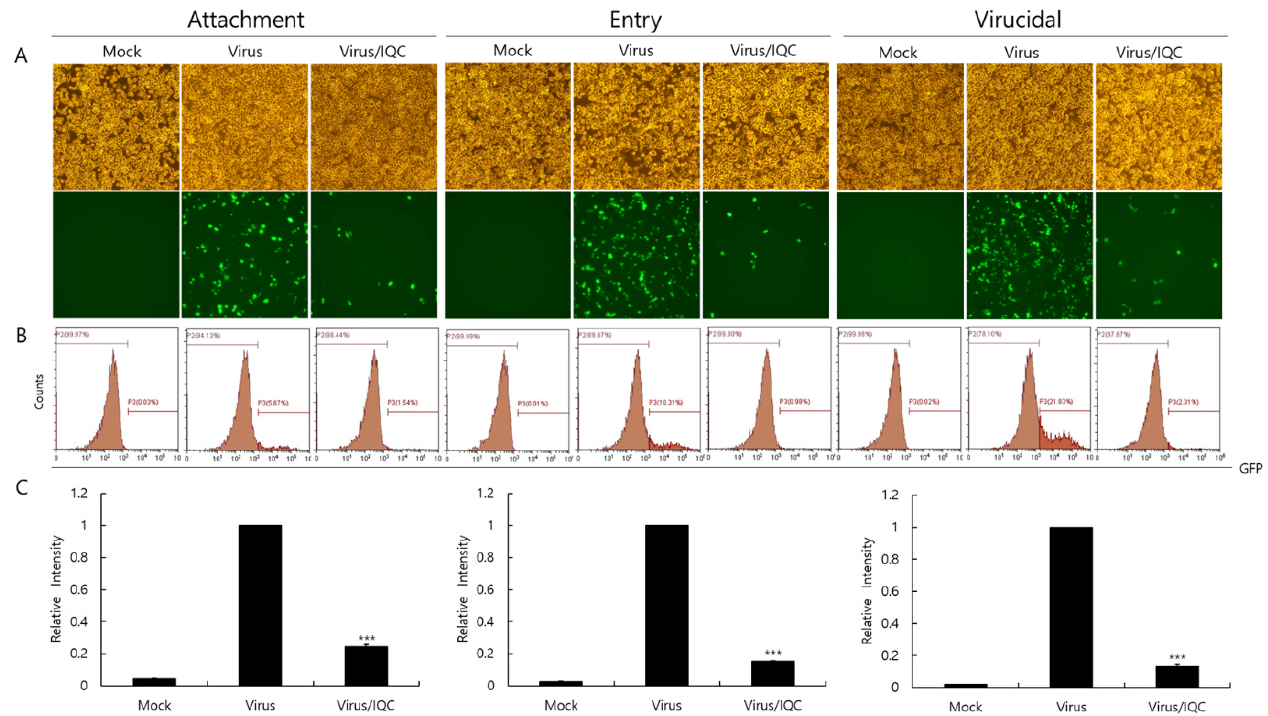
Figure 4. Effect of isoquercitrin on viral attachment, entry, and virucidal stages. ( A – C ) For checking the effect of IQC on the attachment stage, RAW 264.7 cells were cotreated with PR8-GFP IAV at 10 MOI and IQC at 25 µ M for 30 min at 4 ◦ C. After washing, the cells were incubated for 24 h at 37 ◦ C. To examine the effect of IQC on the entry stage, the cells were infected with 10 MOI PR8-GFP IAV at 4 ◦ C for 30 min, followed by the treatment of 25 µ M IQC for 30 min at 37 ◦ C. After washing, the cells were incubated for 24 h at 37 ◦ C. For investigation of the effect of IQC on the virucidal stage, 10 MOI PR8-GFP IAV and 25 µ M IQC were mixed and incubated for 30 min at 4 ◦ C. The cells were added with the mixtures and incubated for 30 min at 37 ◦ C. After washing, the cells were incubated for 24 h at 37 ◦ C. ( A ) The cell images were captured using fluorescence microscopy with 200 × magnification. ( B , C ) The cells were fixed with paraformaldehyde and analyzed using FACS. The levels of GFP expressed in the cells were calculated by comparison with PR8-GFP IAV. The data represent the mean ± SD value based on three independent experiments. Statistical significance was assessed via an unpaired Student t -test. *** p <